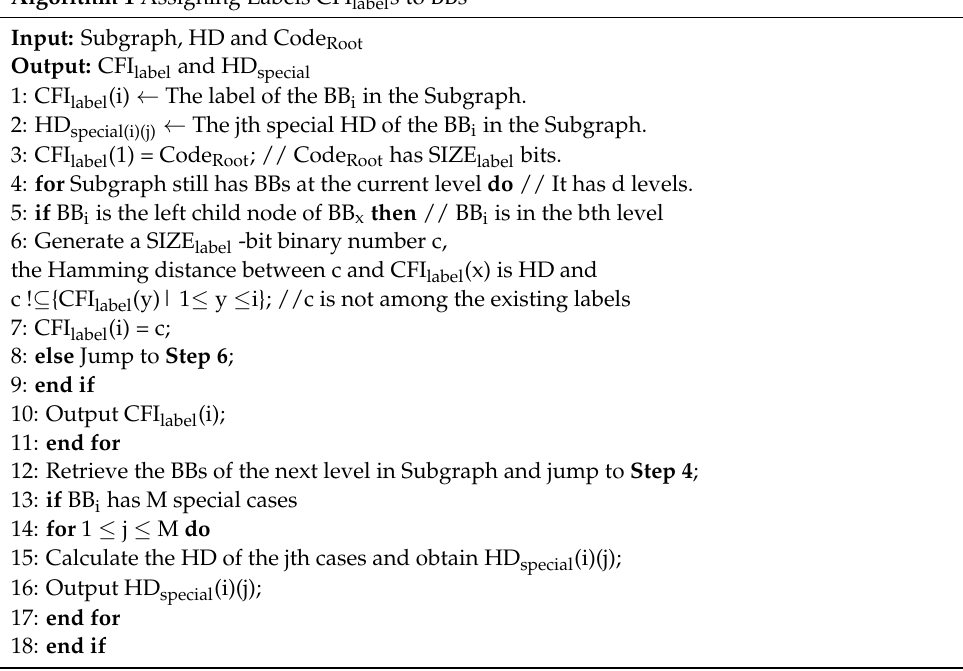
Algorithm 1 Assigning Labels CFI label s to